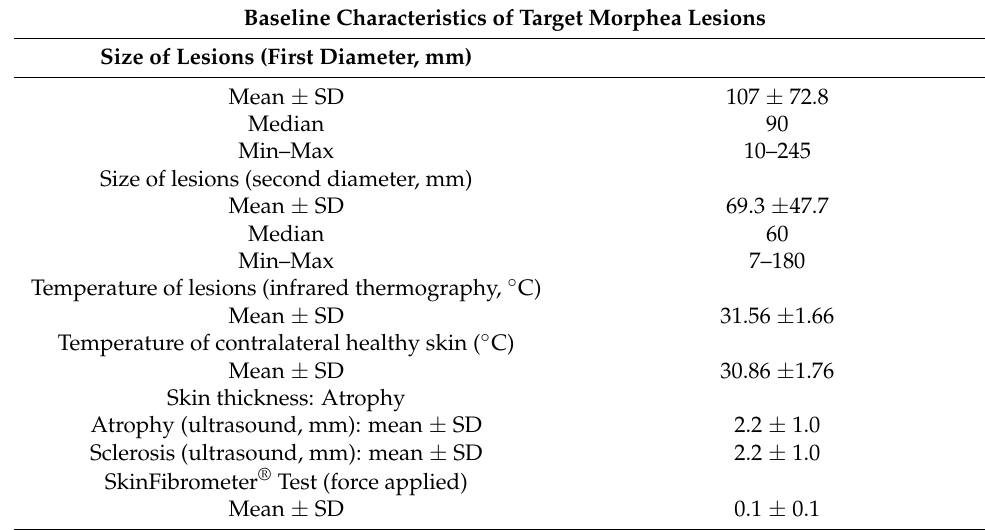
Table 1. Quantitative description of target morphea lesions at baseline (SD: standard deviation).